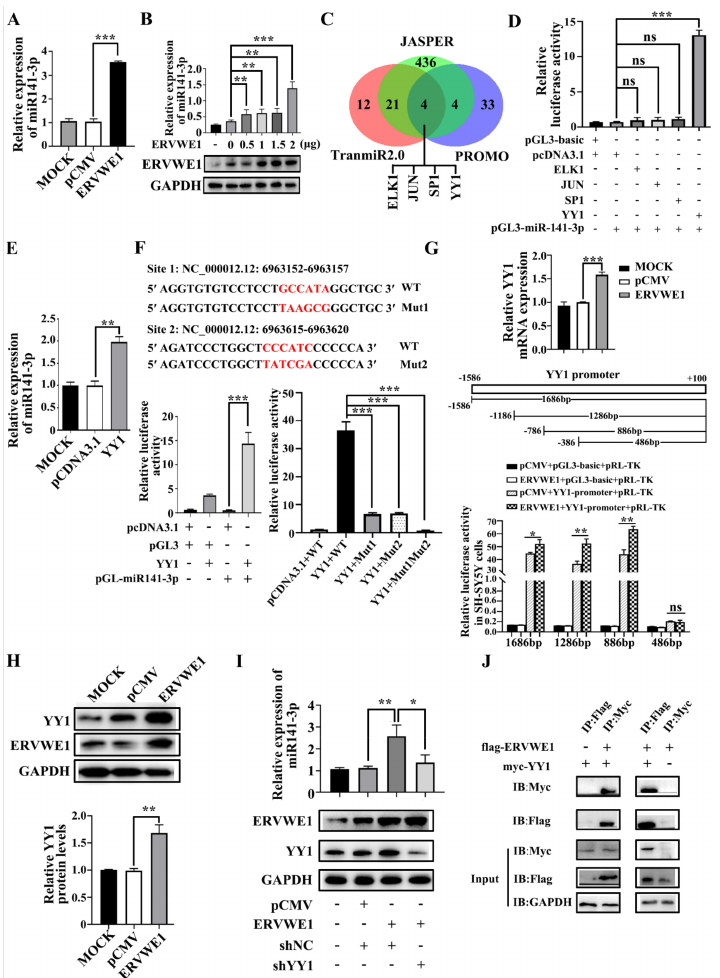
Figure 2. ERVWE1 promoted the expression of miR-141-3p through binding with TF YY1. ( A ) The upregulation of miR-141-3p in ERVWE1-transfected SH-SY5Y cells was validated by RT-qPCR. ( B ) The results showed that in SH-SY5Y cells containing different amounts of ERVWE1 expression plasmids (0 µ g, 0.5 µ g, 1 µ g, 1.5 µ g, 2 µ g), miR-141-3p expression levels increased with the concentration of plasmid. ( C ) Prediction results showed that four TFs (ELK1, JUN, SP1, and YY1) might